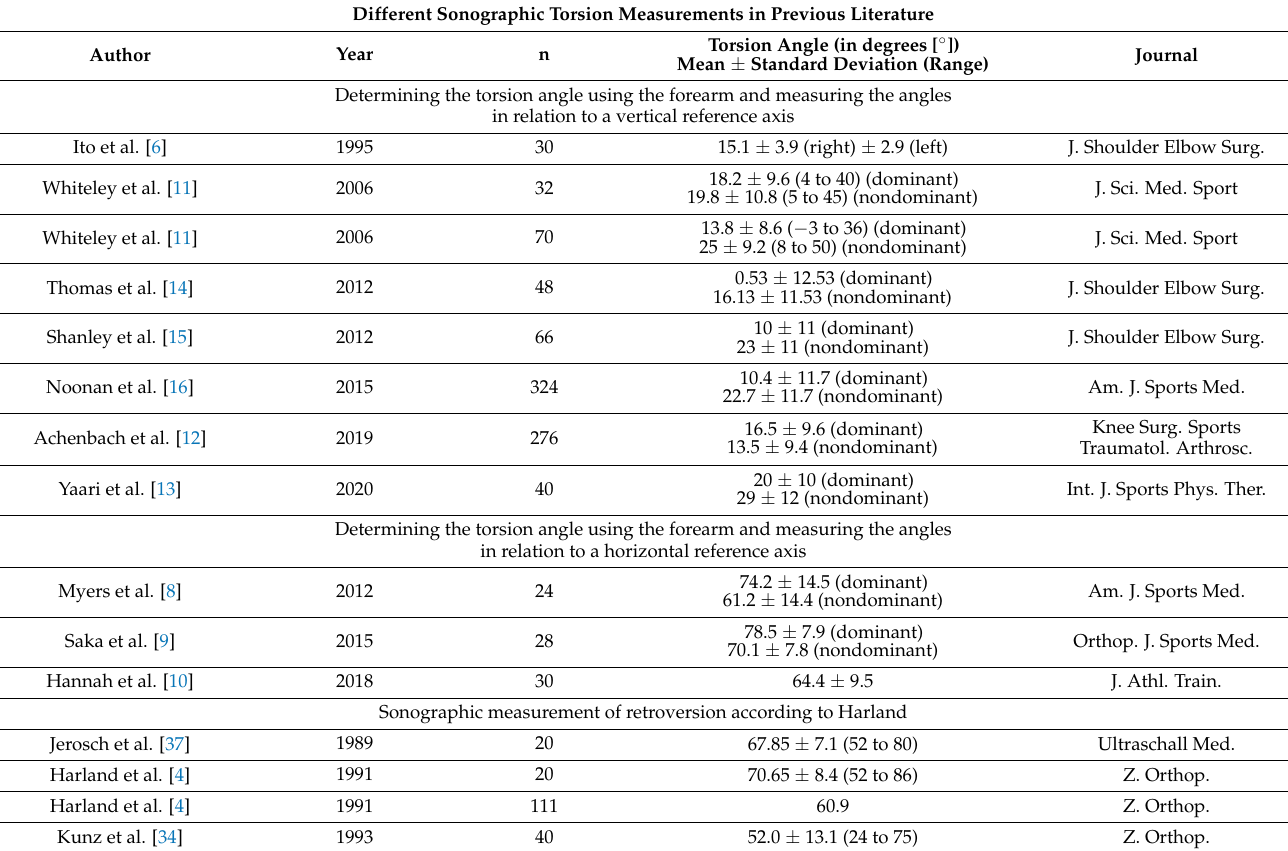
Table 2. Different sonographic torsion measurements in previous